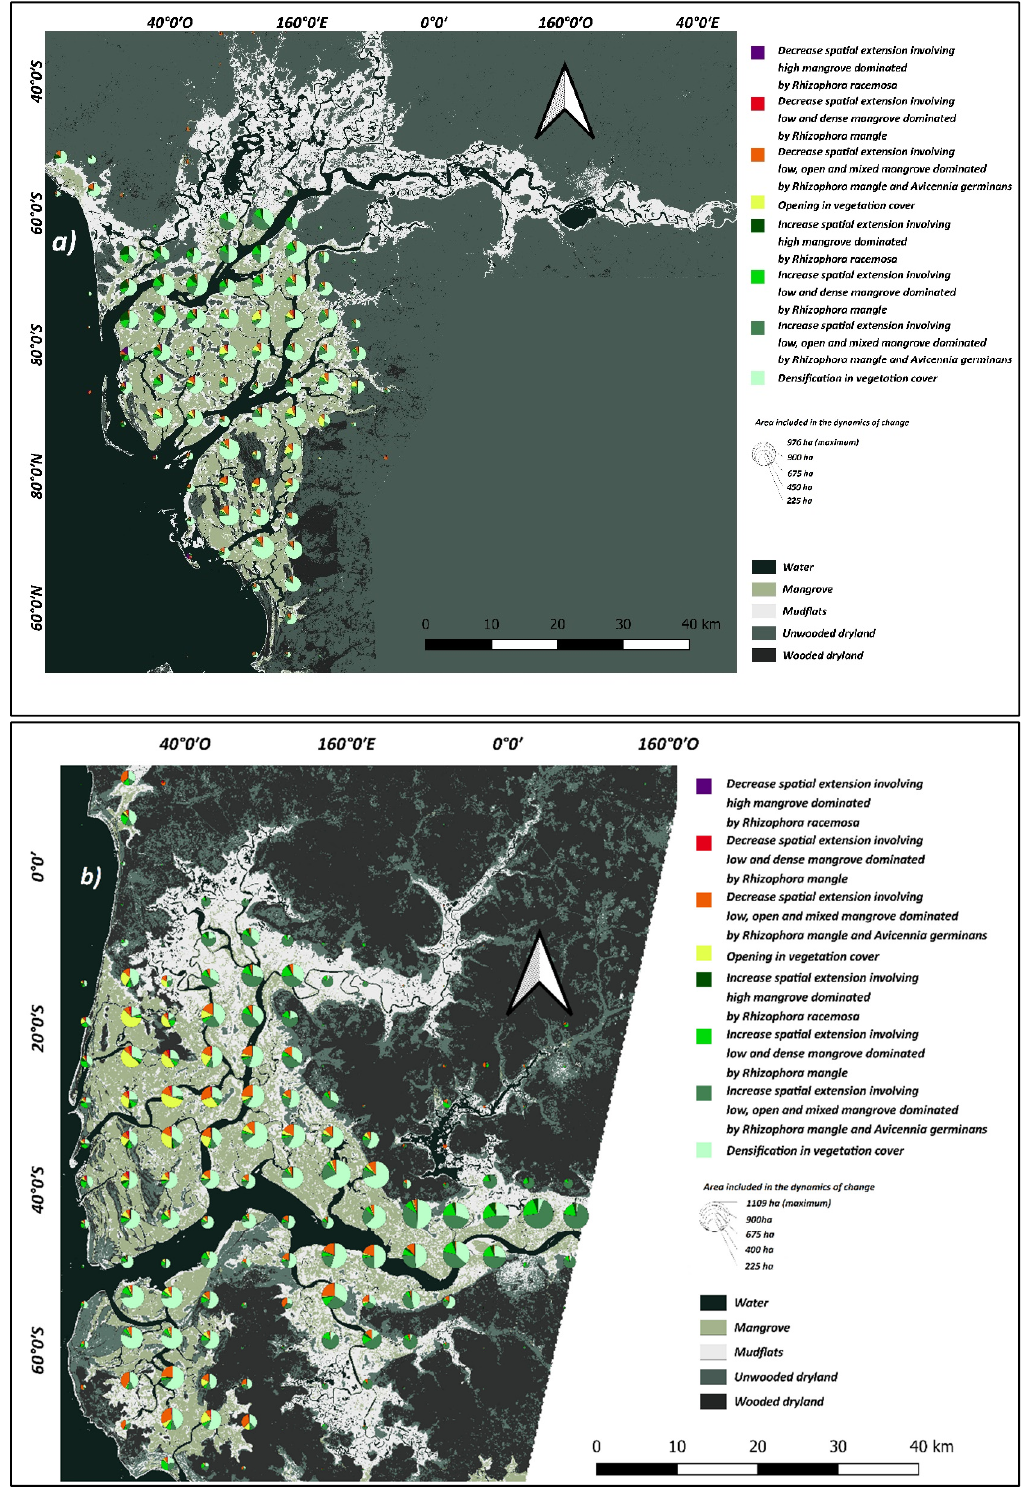
Figure 8. Synthesis of the main dynamics of mangrove surfaces in the change process: ( a ) Saloum and ( b ) Casamance (the relative sizes of the symbols indicate the importance of the mangrove areas included in the local dynamics).